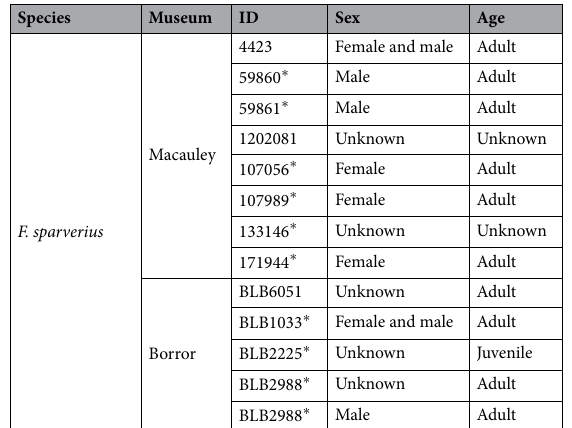
∗ Used only for song structure analysis.